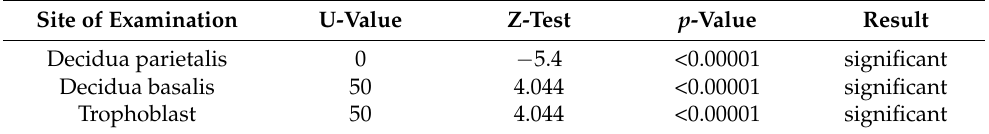
Table 7. CD8 + comparison among the experimental (RPL) and control (electively abortion) group. Site of Examination